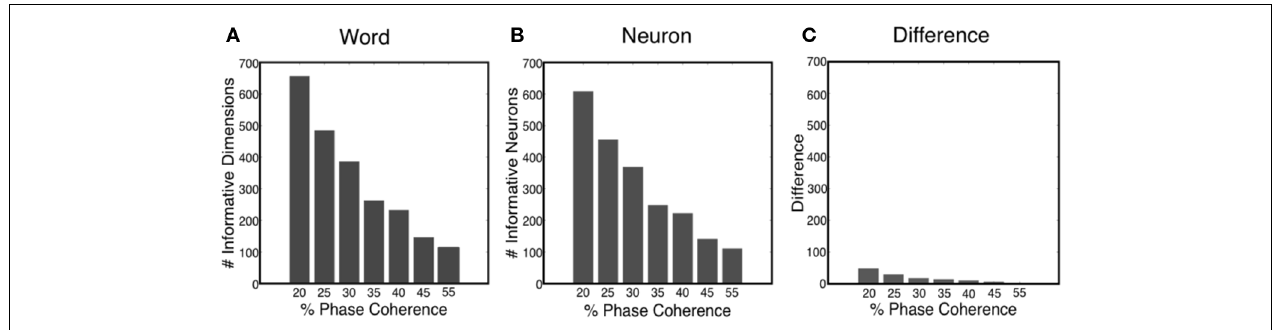
FIGURE 11 | (A) Number of informative dimensions decrease as the task becomes easier. (B) Number of informative neurons decreases as the task becomes easier. (C) Difference between the number of informative dimensions and the number of informative neurons.